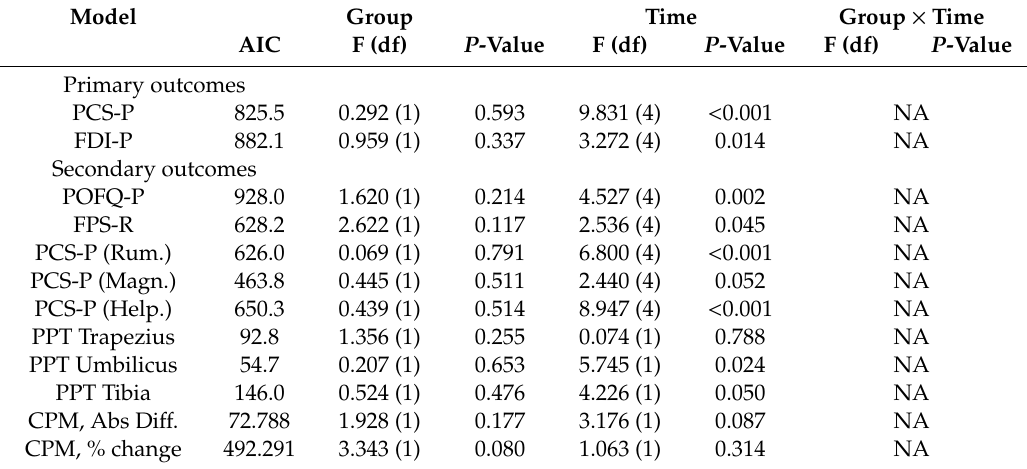
Table 2. Main group, time, and interaction e ff ect for the primary and secondary outcomes.